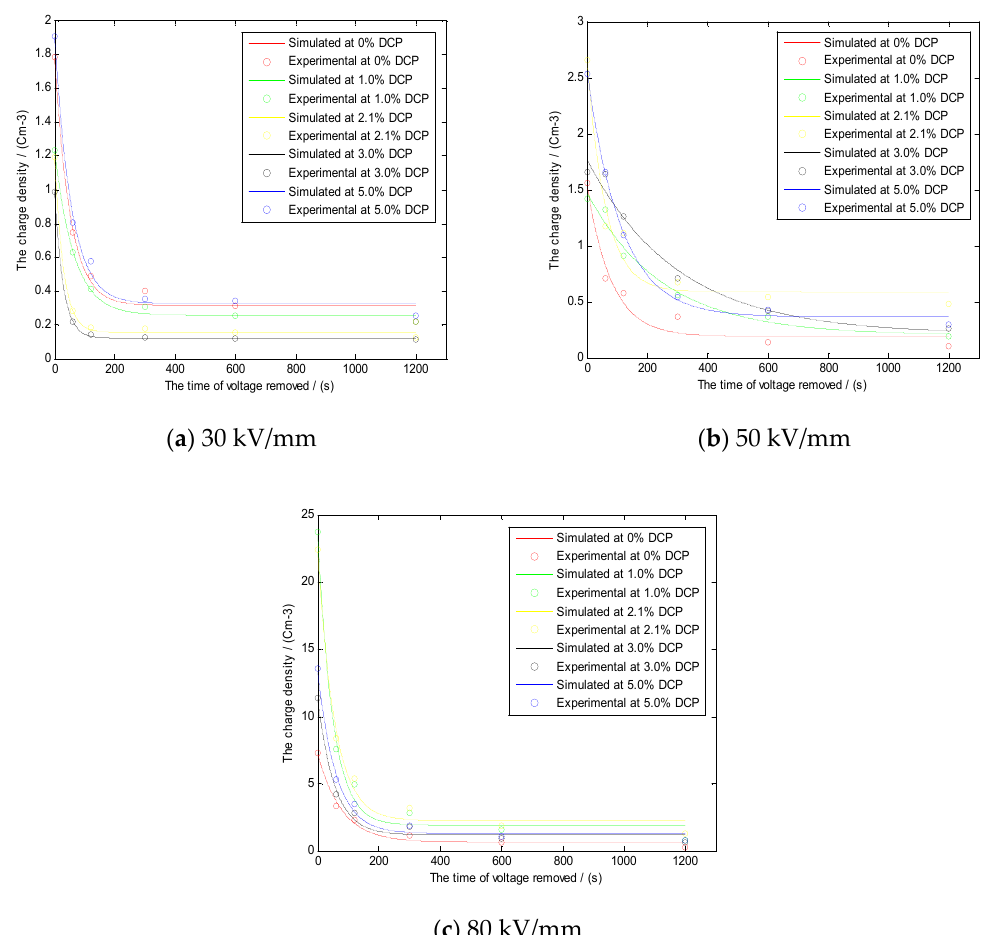
Figure 12. The comparison between the theoretical results obtained by the above model and the real experimental results after the action of, respectively, 30 kV / mm, 50 kV / mm, and 80 kV / mm. ( a ) The comparison after the action of 30 kV / mm. ( b ) The comparison after the action of 50 kV / mm. ( c ) The comparison after the action of 80 kV / mm. (the sample with 0%DCP in the legend is the pure LDPE)